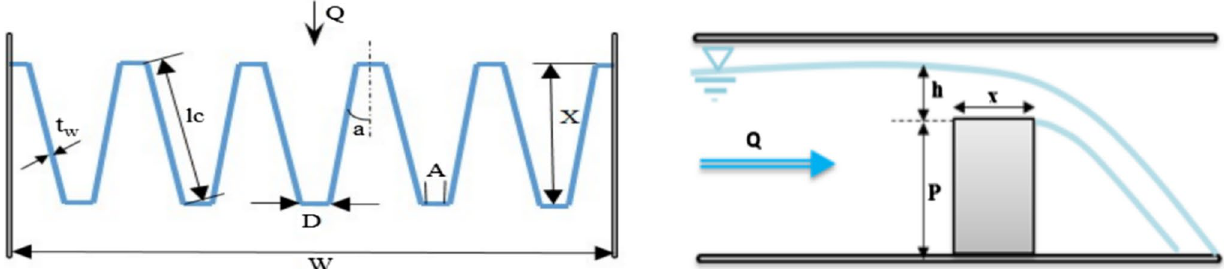
Fig. 1 A view of a labyrinth weir investigated by Crookston and Tullis